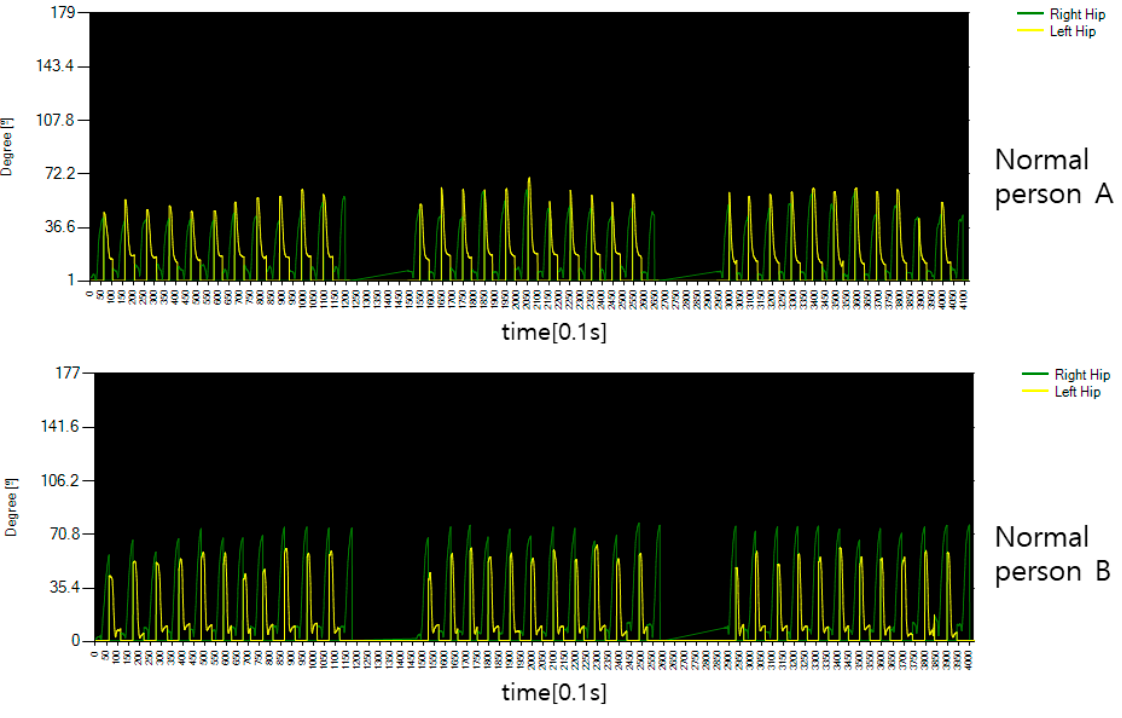
Figure 16. The hip joint angle data of the motion that rotates the body of an average healthy